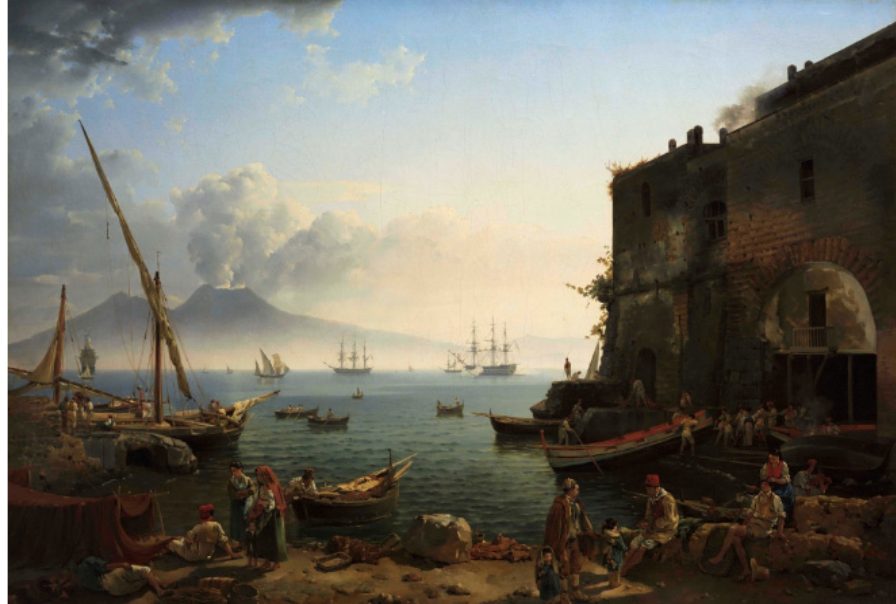
Figure 28. Sylvester Shchedrin. The Embankment of Santa Lucia , 1829. State Russian Museum, Saint Petersburg.